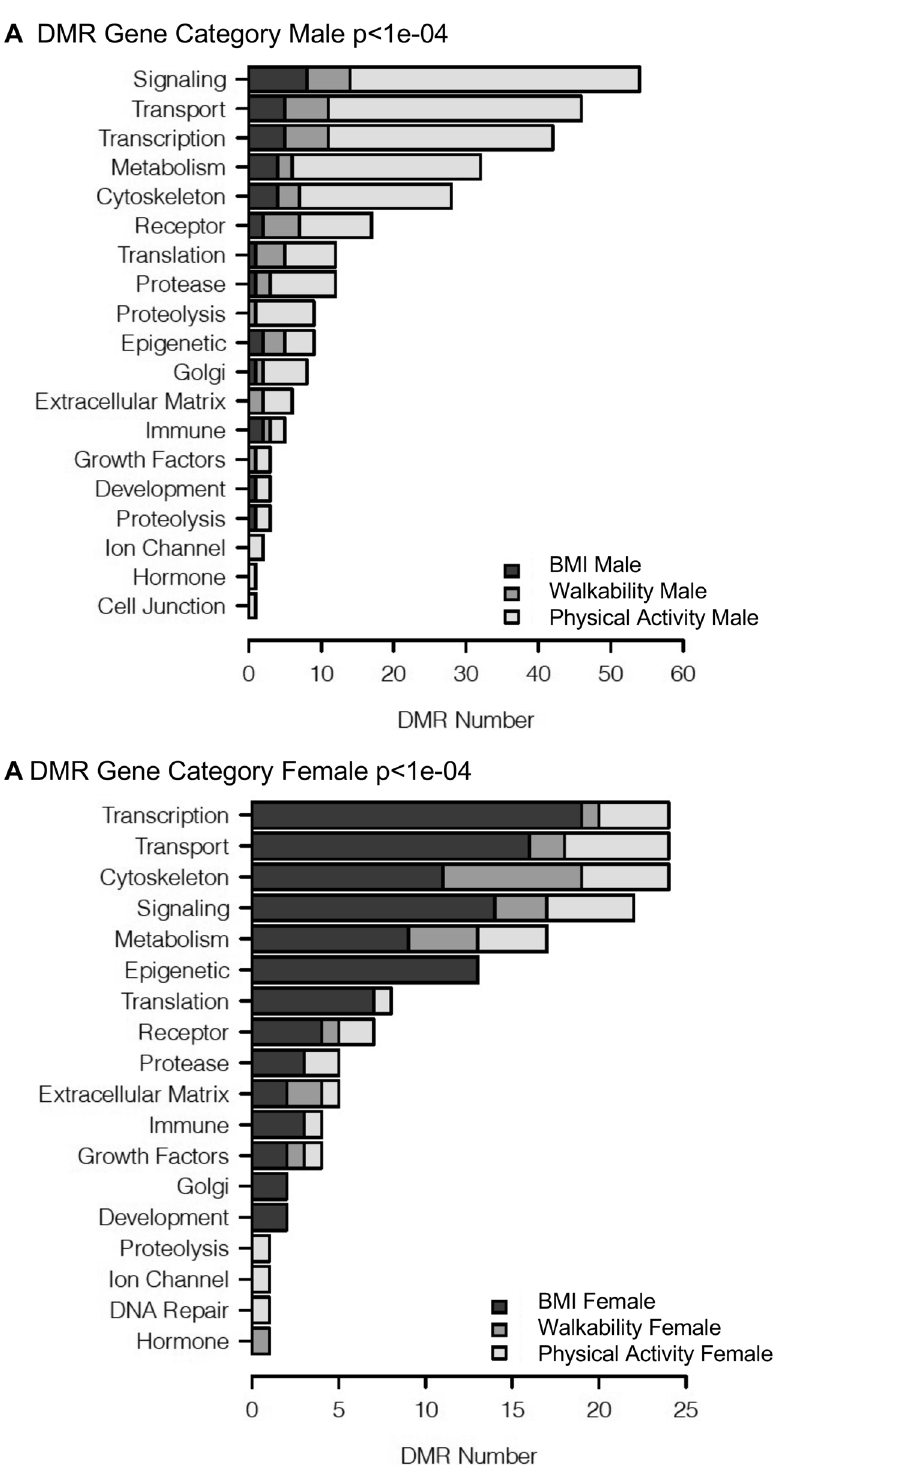
Figure 8. DMR gene categories. ( A ) Male ( B ) Female, with inset legends for the distinct DMR